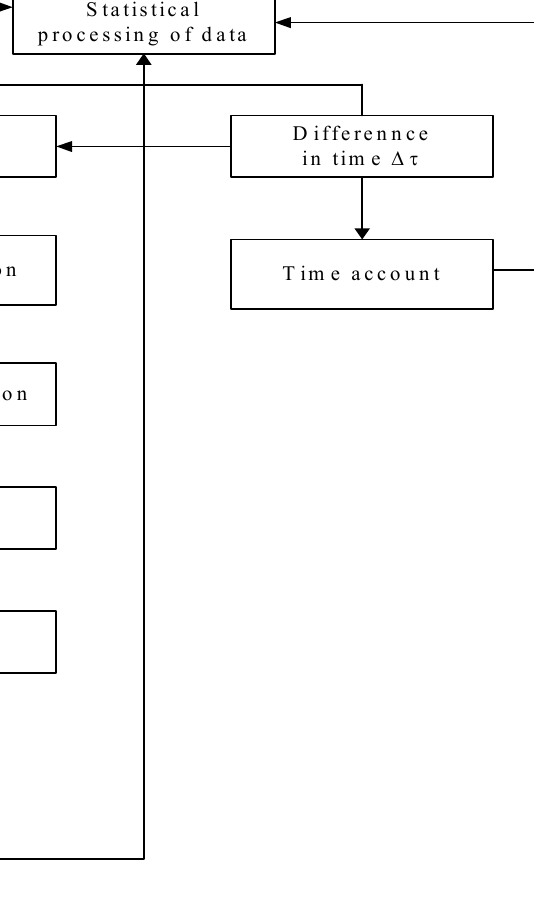
Fig 8. Diagram of the computer